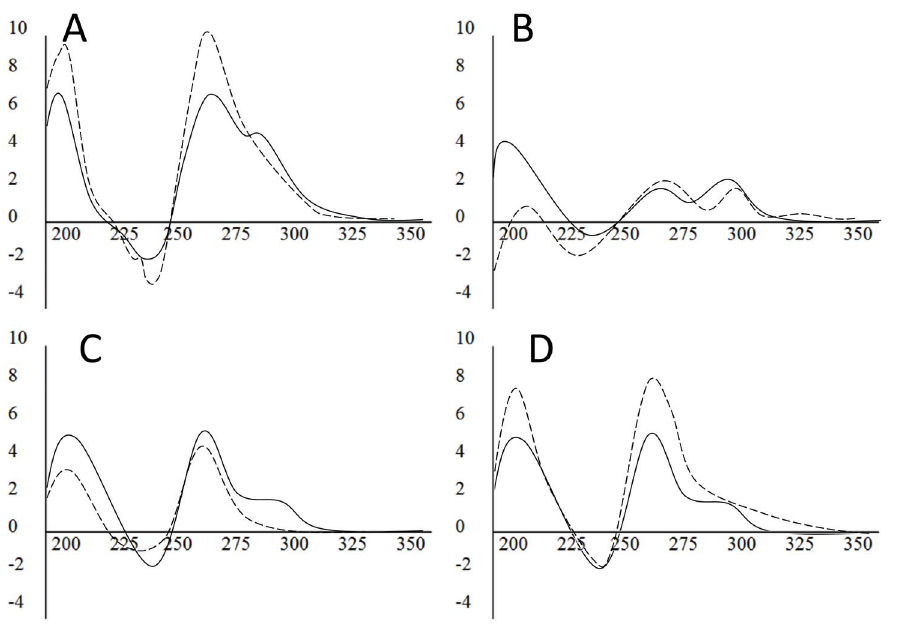
Figure 3. Comparison of G4 conformation in different buffers. CD spectra for G4MEST1L (A), G4MEST2 (B), and G4MEST3 (C) in NaPi, 50 mM KCl (solid line) or PCR buffer (dashed line). (D) CD spectra for G4MEST3 in NaPi, 50 mM KCl (solid line) or NaPi containing 50 mM KCl and 1.5 mM Mg 2 + (dashed line). Molar ellipticity (x10 5 deg.cm 2 .dmol 2 1 ) is on the vertical axis and wavelength (nm) is on the horizontal axis.